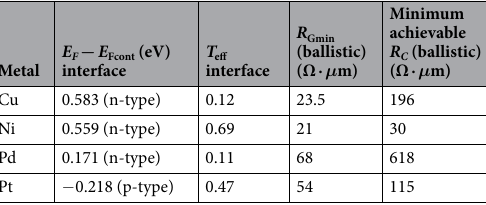
Table 4. Evaluation of minimum achievable contact resistance. The minimum asymptotic contact resistance achievable for different metals in the situation illustrated in Fig. 7(f) is shown in the last column. We have considered T off and E Fcont extracted from ab-initio simulations on the medium structure. R Gmin is the ballistic resistance of graphene per unit width for the corresponding E F − E Fcont . The contact asymptotic resistance is obtained as R Gmin / T eff